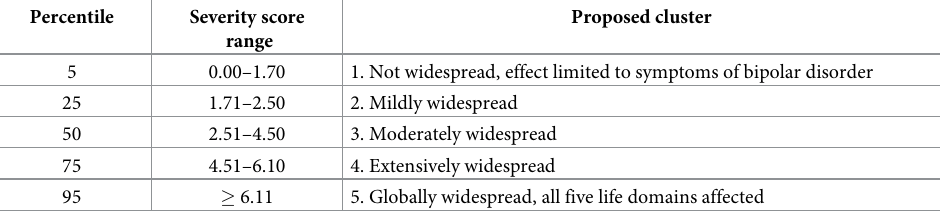
Table 3. Percentiles, severity score range values, and proposed clusters.